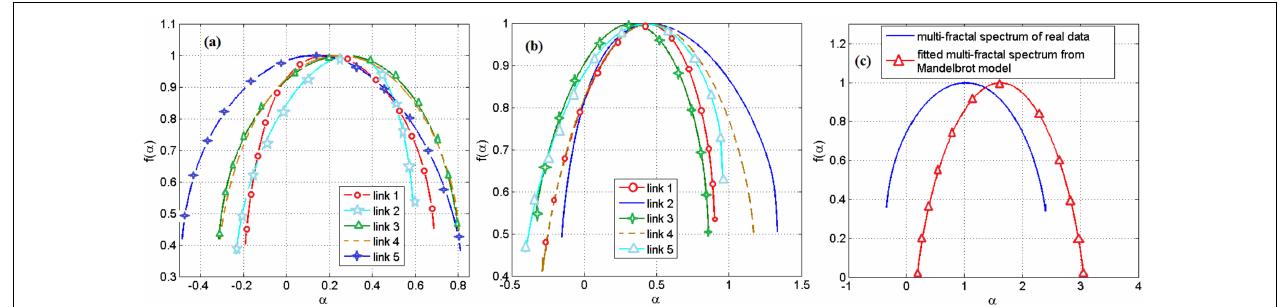
FIGURE 4 | (a) Multifractal spectrum of several randomly picked links of gene regulatory network of E. coli . (b) The multifractal spectrum of several randomly picked links of gene regulatory network of S. cerevisiae . (c) The multifractal spectrum of a link between the gene regulatory network of S. cerevisiae and the best spectrum from the Mandelbrot binomial